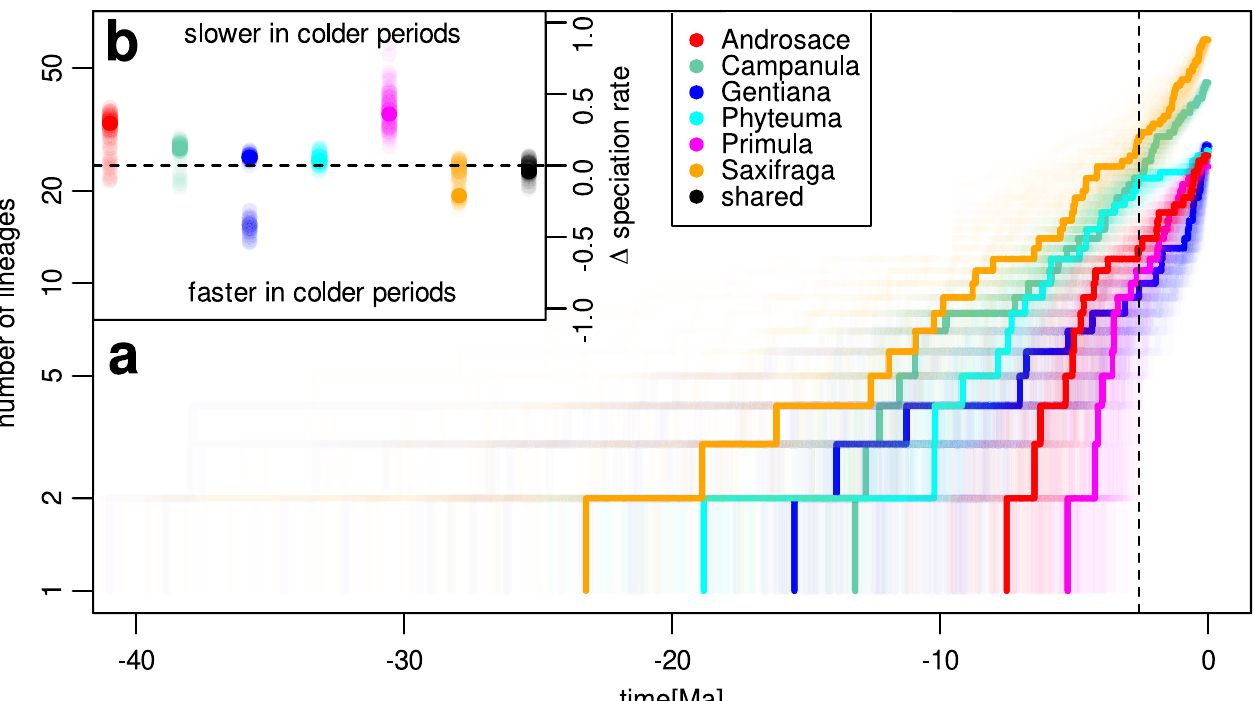
Fig. 2 Tempo of species diversi fi cation for the six study lineages. a Lineage-through-time curves of each lineage. The thick lines represent maximum credibility phylogenetic reconstructions, while the semi-transparent lines represent 100 trees sampled from Bayesian posterior distributions. The dashed line marks the onset of the Pleistocene at 2.6 Ma before present. The number of lineages is plotted in logarithmic scale, i.e. the exponential growth expected under pure birth model would appear linear here. b Parameter estimates indicating the effect size of the temperature control on speciation rates in temperature-dependent models of species diversi fi cation ( Δ speciation rate). The black dots represent the estimates from the multi-clade model with shared parameters among lineages. Higher values above the dashed line indicate lower speciation in colder geological periods. Thick dots correspond to estimates based on the maximum credibility phylogenetic trees, and semi-transparent dots on the 100 trees sampled from the posterior distribution. Source data are provided as a Source Data fi